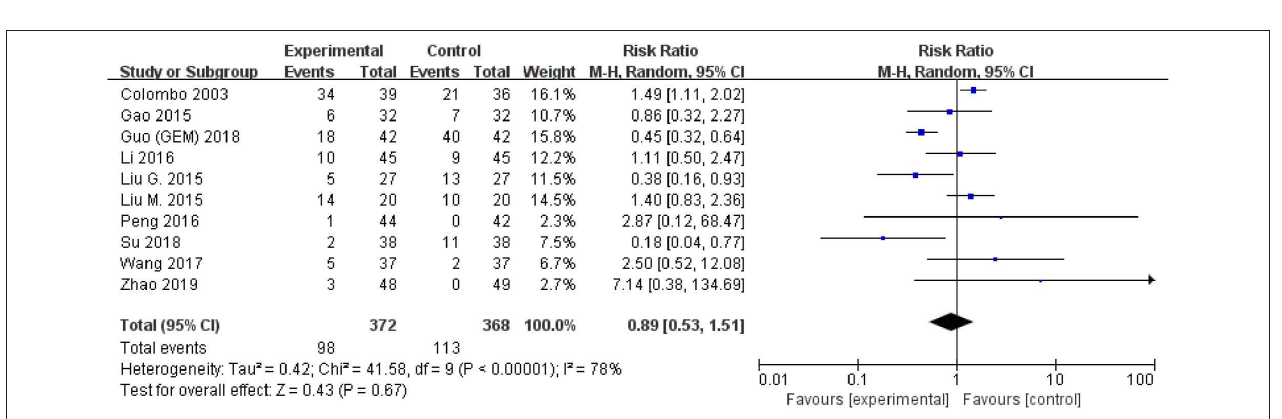
s 23 month follow-up (31). All these literature show the same point that thermal intravesical chemotherapy demonstrated a tumor cell killing effect which might be a good for NMIBC